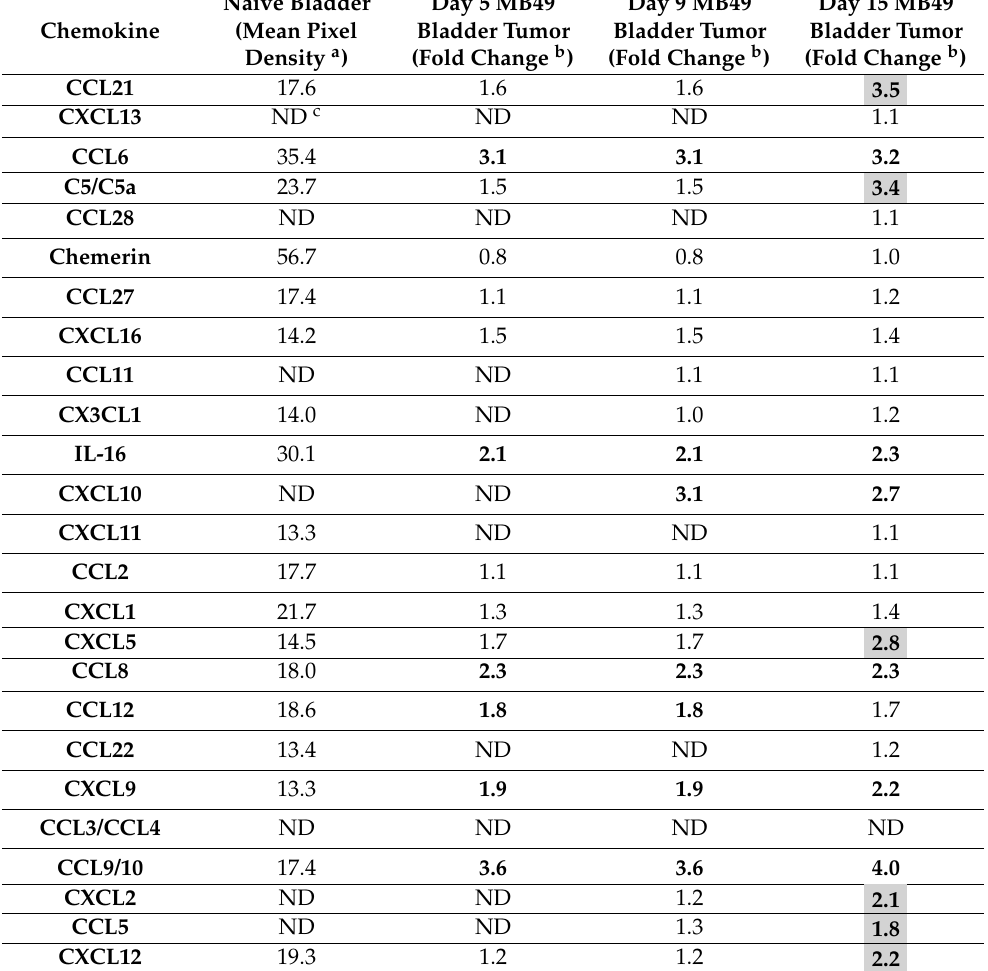
Table 1. Chemokine levels in naïve bladder tissue and in growing MB49 bladder tumors. Naïve Bladder Chemokine (Mean